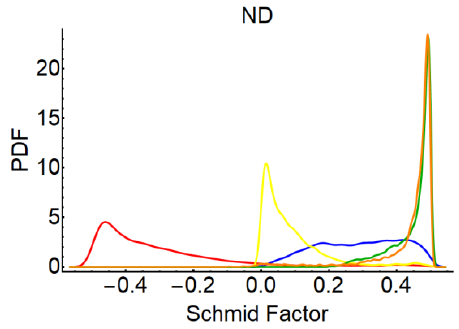
Figure 2. Histograms of SF of the initial texture for extension twinning and basal slip.